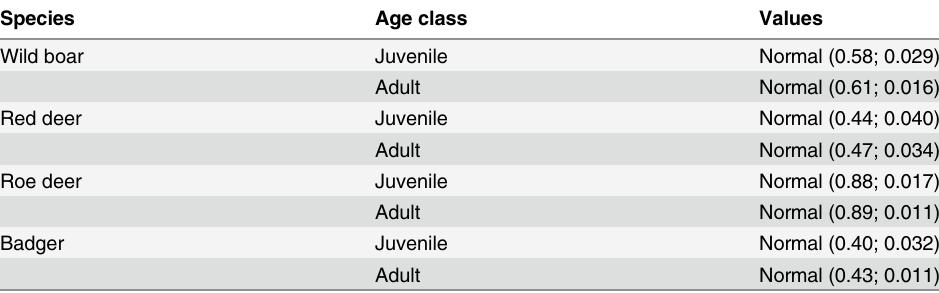
Table 6. Probability of TBLs being detected on an infected animal at the laboratory by qualified staff, by species and age